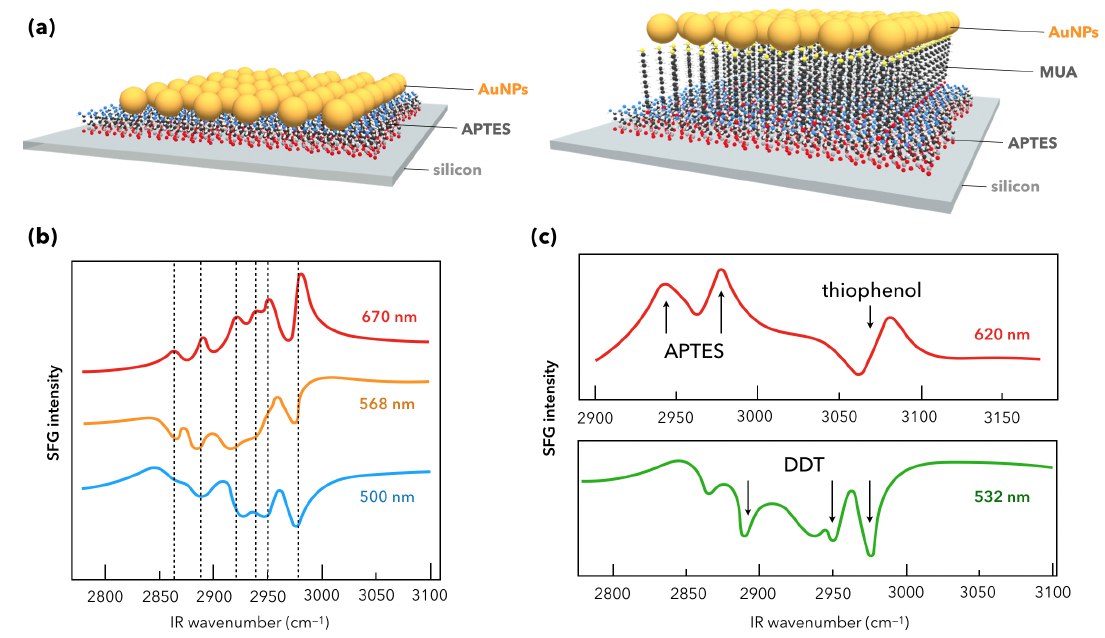
Figure 10. ( a ) AuNPs/APTES/Si (or AuNPs/MUA/APTES/Si) interfaces before functionalization with thiophenol or dodecanethiol (DDT). ( b ) 2C-SFG spectra of the AuNPs/APTES/Si interfaces for three different incident visible wavelengths from blue to red as indicated on the picture. The complete shape-reversal of the APTES vibrational signature between the blue and red curves is well marked. ( c ) SFG spectra for specific incident wavelength revealing the vibrational fingerprint of thiophenol ( top ) or DDT molecules ( bottom ) chemically adsorbed on two different AuNPs/APTES/Si interfaces, respectively. Figure panel is adapted from reference